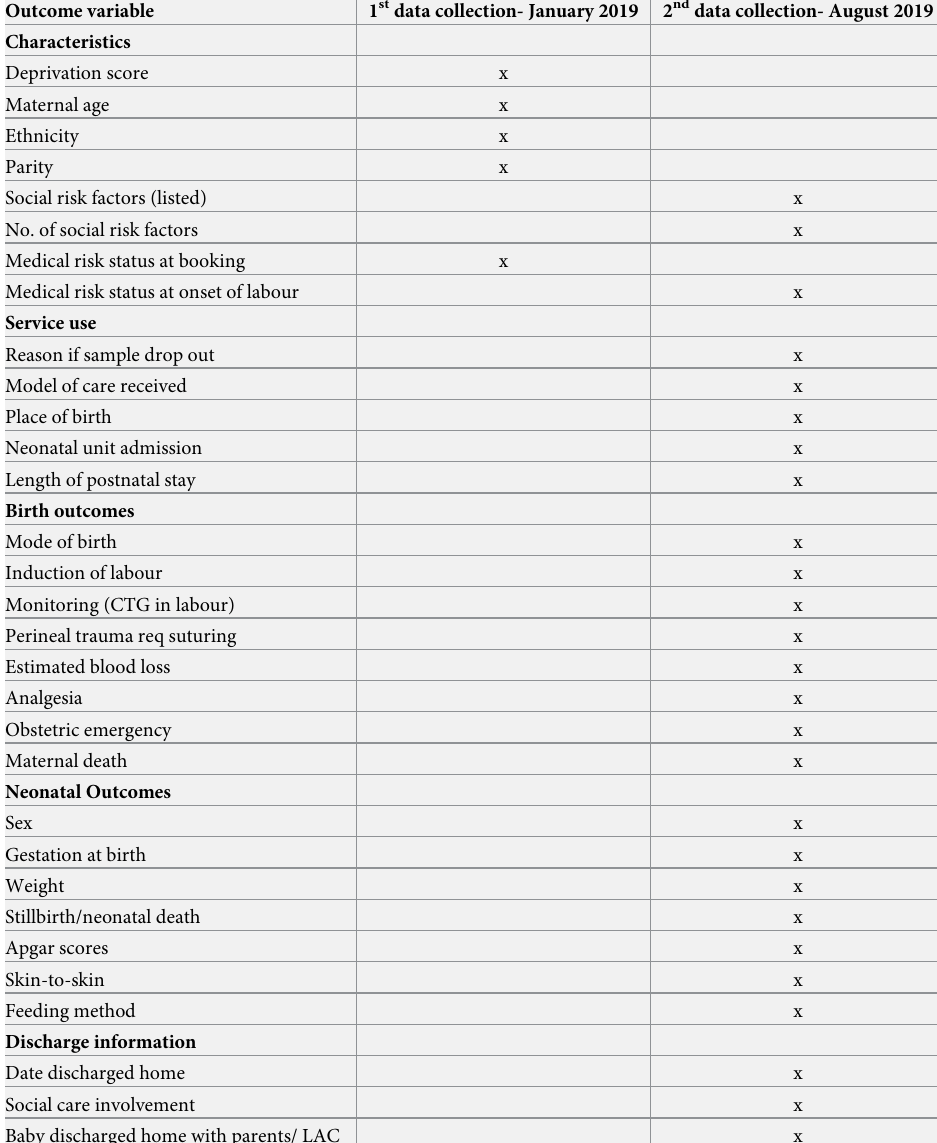
Table 2. Outcome variables collected at two time